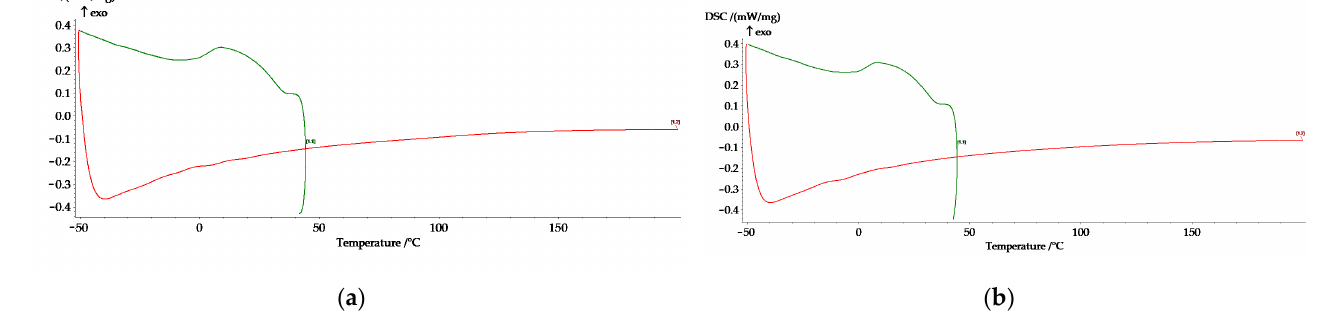
Figure 4. DSC diagrams for: ( a ) C; ( b ) HR samples. Table 3. DSC results from the cooling curve of FeMnSiAl